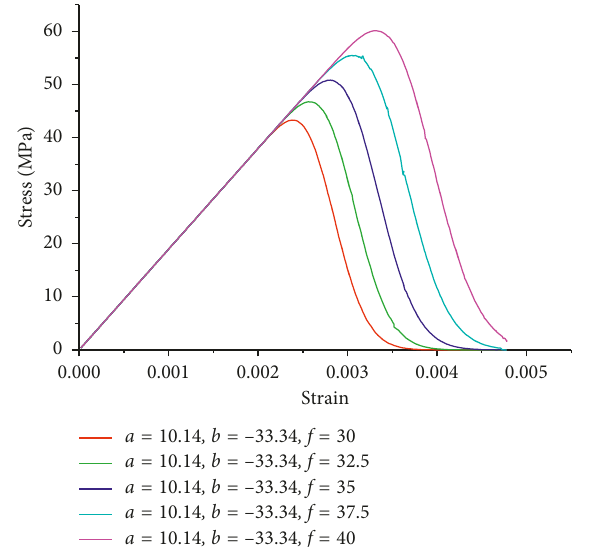
Figure 5: Impact of internal friction angle φ on the constitutive model.